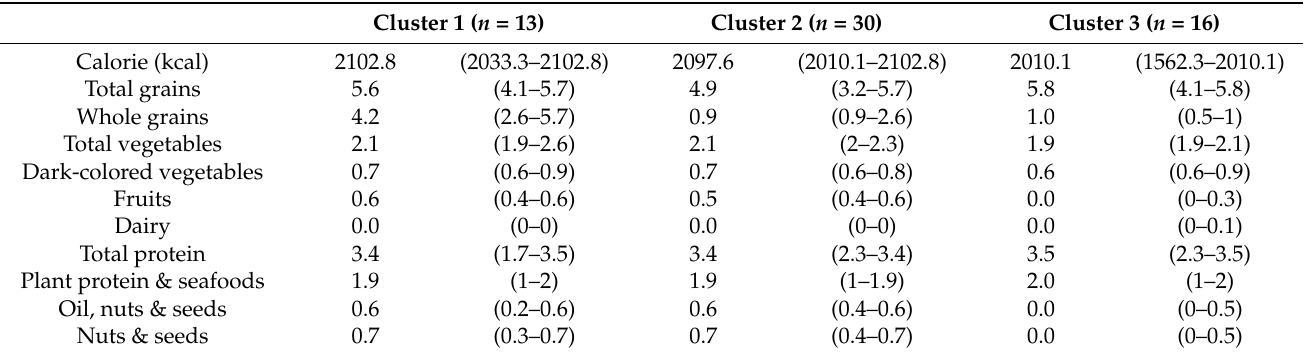
Table A2. Median (IQR) intake of six food groups per 1000 kcal density across dietary